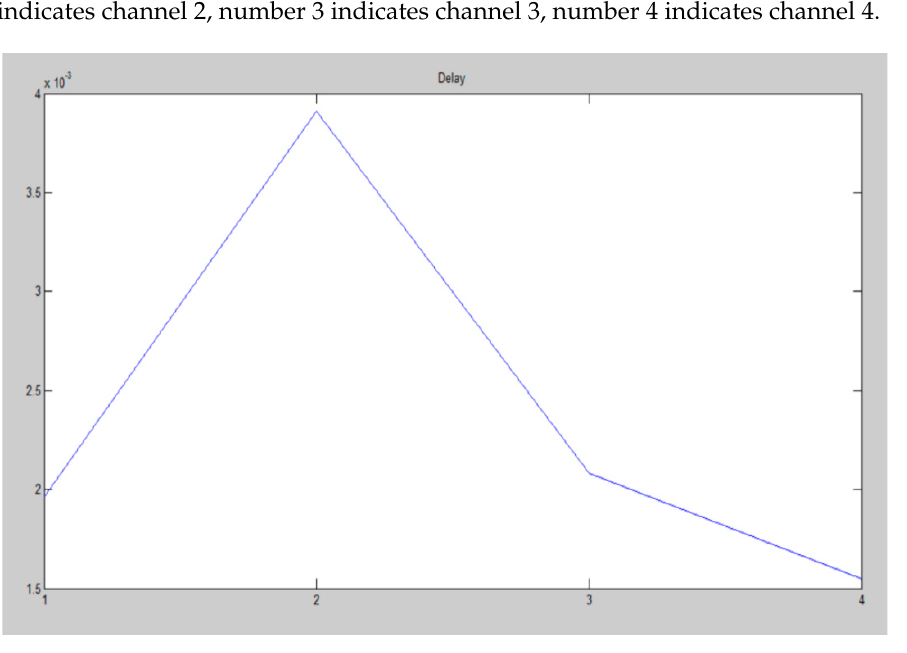
Figure 13. Delay parameter. Figure 13. Delay Table 11 is the number of delay on each channel. Table 11. Delay parameter.